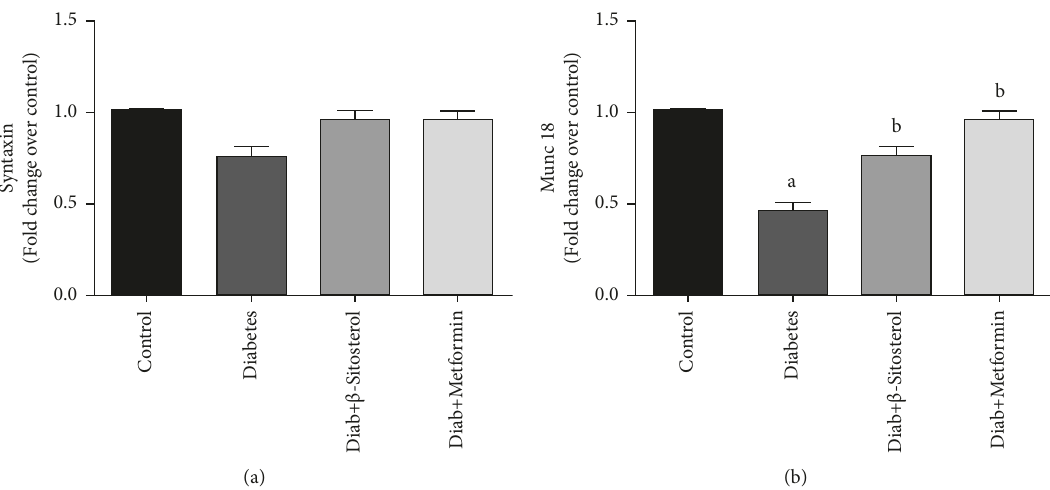
Figure 8: (a and b): The effect of β -sitosterol on the mRNA expression levels of syntaxin and Munc 18 in HFD and sucrose-induced diabetic rats was measured by real-time PCR. Mean ± SEM of 6 animals was represented in each bar. The values, which were significant ( p < 0 . 05), were compared with a–control and b—diabetic control. Data from (a) reveal that the expression of syntaxin mRNA resulted in no significant change between the groups studied. (a) Syntaxin mRNA. (b) Munc 18 mRNA.